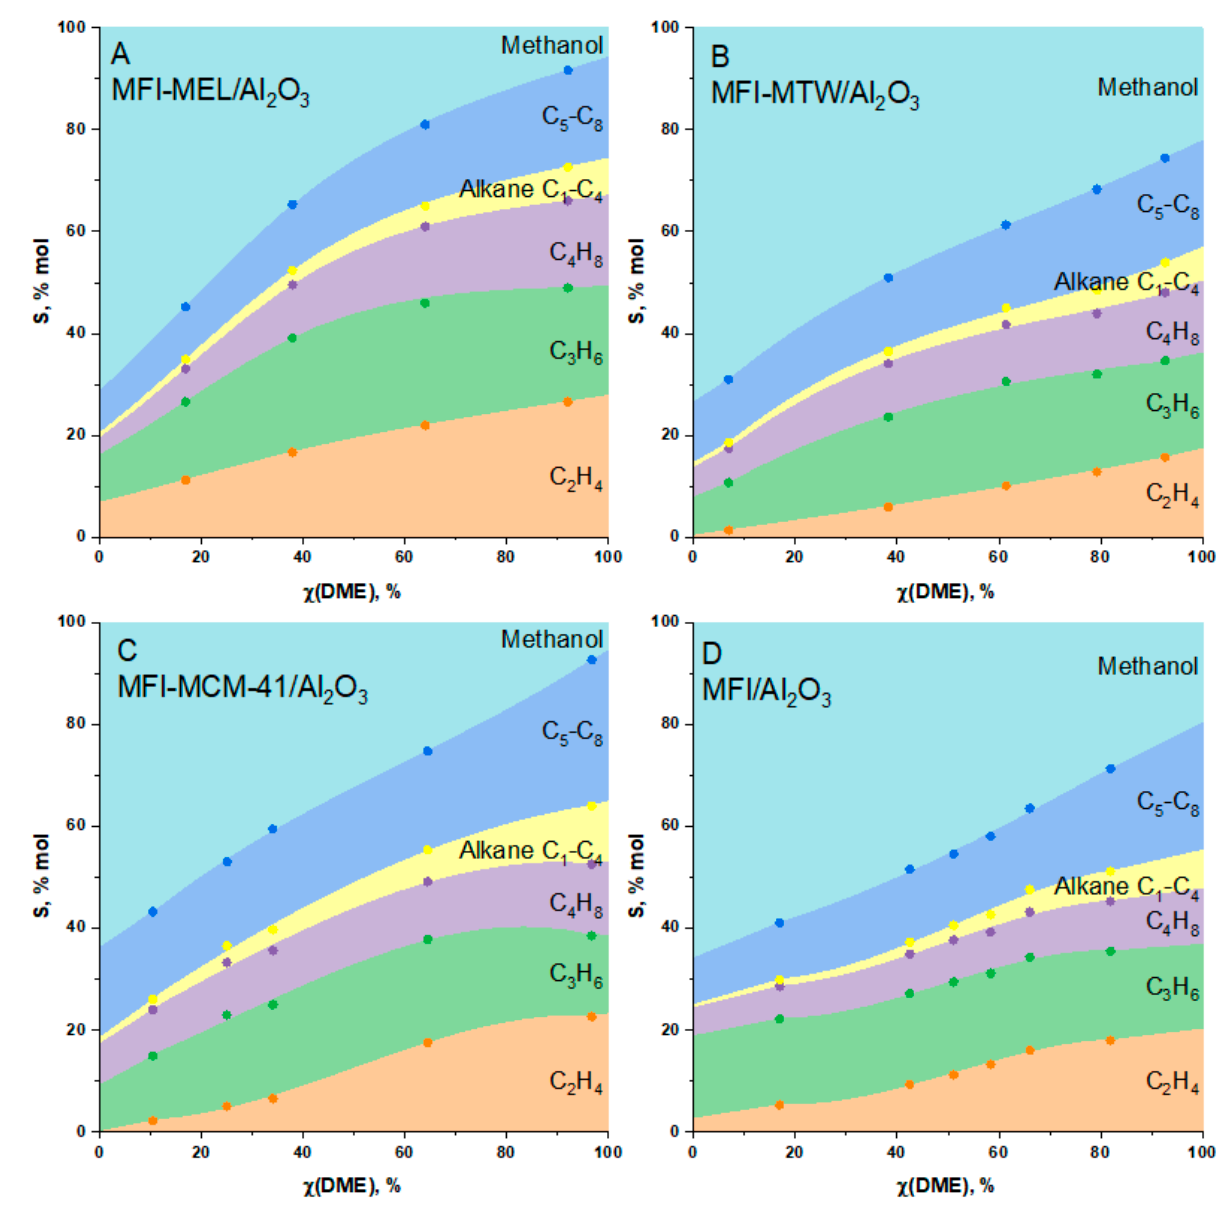
Figure 4. Dependence of the product selectivity (C 2 ‐ C 4 olefins, C 1 ‐ C 4 alkanes, C 5 ‐ C 8 hydrocarbons, and methanol) on DME conversion on catalysts ( A ) MFI ‐ MEL/Al 2 O 3 , ( B ) MFI ‐ MTW/Al 2 O 3 , ( C ) MFI ‐ MCM ‐ 41/Al 2 O 3 , ( D ) MFI/Al 2 O 3 . p = 1 atm, T = 340 °C. On the catalyst based on hybrid zeolite MFI-MTW/Al 2 O 3 , the selectivity for ethylene and propylene is 8.3 and 19.4% at 50% DME conversion and 16.4 and 18.8% at 95% DME conversion, respectively. In the range of low DME conversion values, the selectivity of ethylene is close to zero (Figure 4B). The ethylene/propylene ratio ranges from 0.15 to 0.75 (Figure